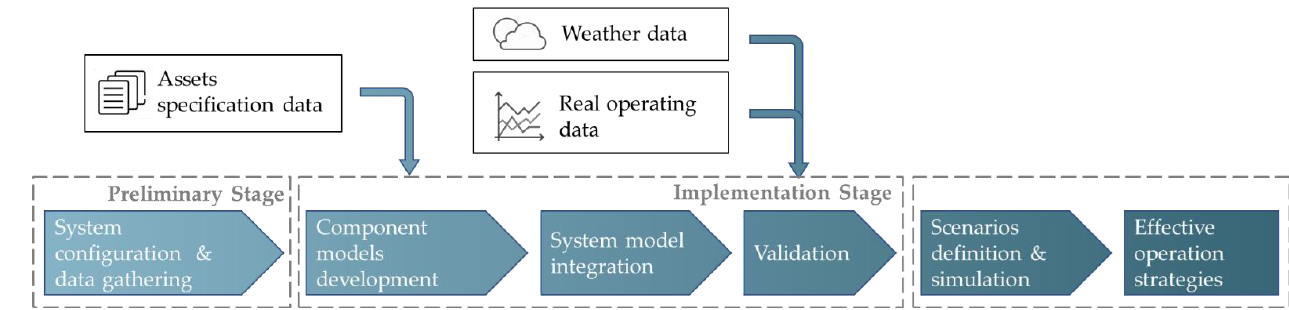
Figure 1. Model development and evaluation methodology that has been followed.